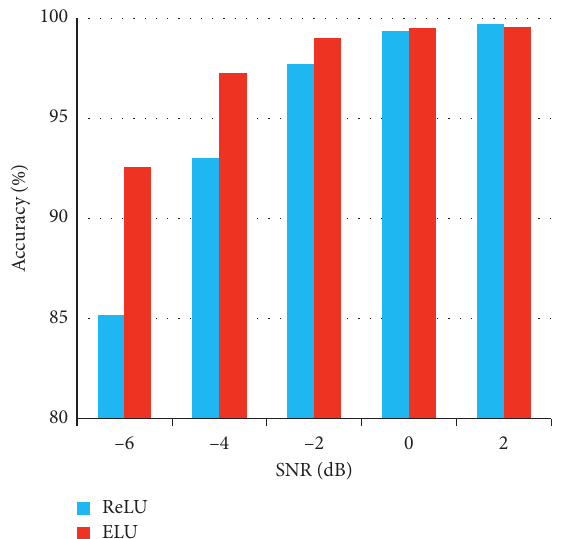
Figure 5: Diagnosis accuracy of MSK-1DCNN with an ReLU or ELU.